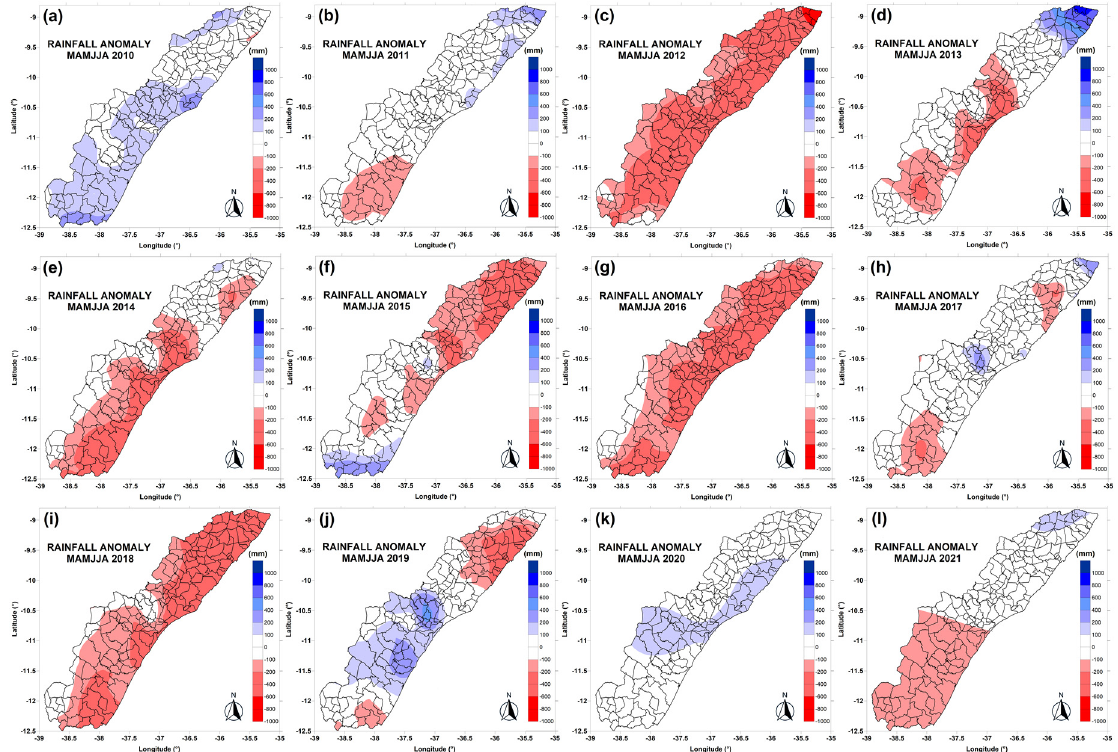
Figure 6. Precipitation anomalies for the rainy semester (MAMJJA) in the SEALBA region, for each year in the 2010–2021 period (which is also the reference period for the calculation of the anomalies). Top row: 2010–2013 ( a – d ); Middle row: 2014–2017 ( e – h ); Bottom row: 2018–2021 ( i – l